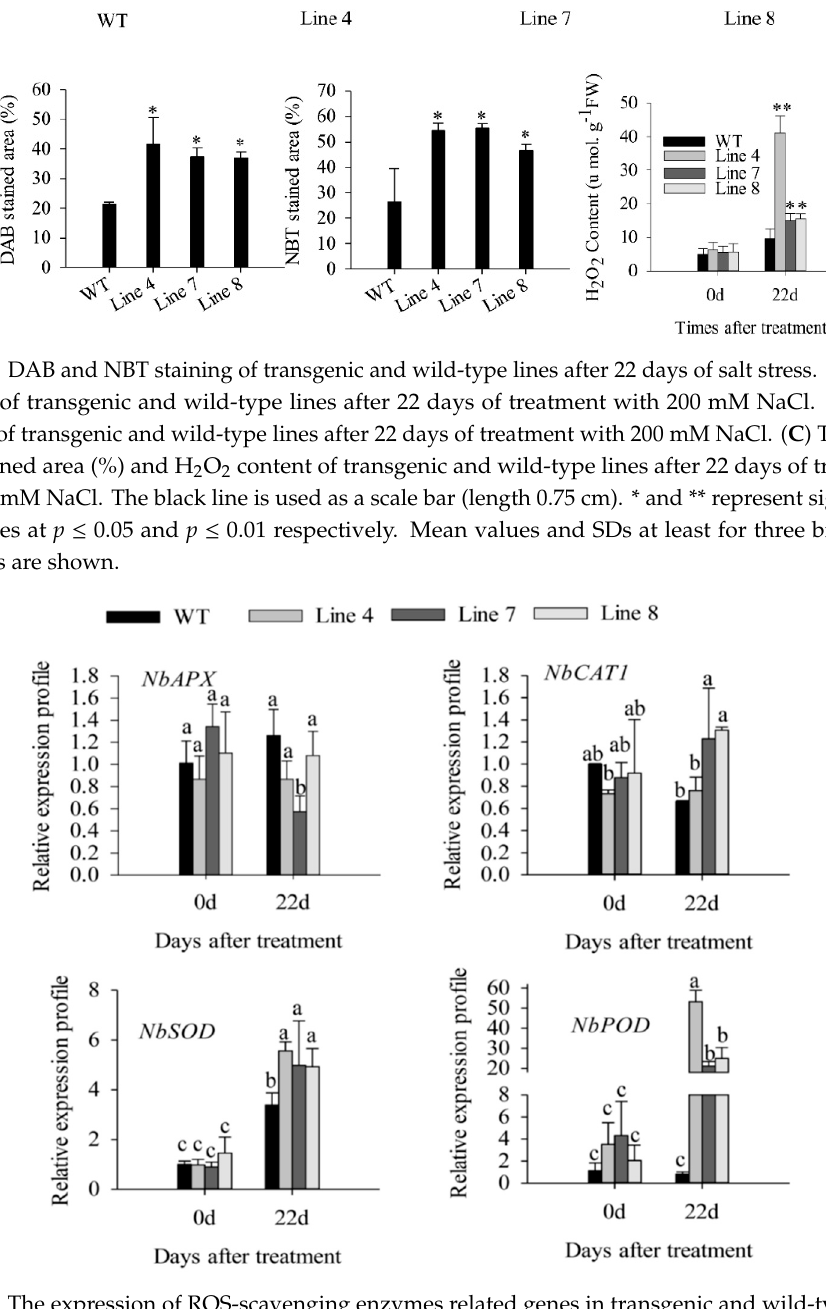
Figure 8. The expression of ROS-scavenging enzymes related genes in transgenic and wild-type lines after 22 days of salt stress. Bars with different letters indicate significant differences at p ≤ 0.05. Mean values and SDs for three biological replicates are shown.